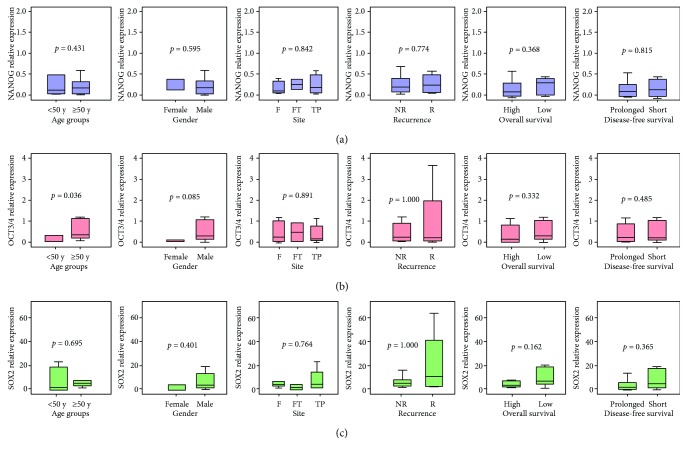
Association between gene expression and the clinicopathological features. Values are presented as medians and quartiles of fold change relative to controls. The box defines upper and lower quartiles (25% and 75%, resp.) and the whisker bars indicate upper and lower adjacent limits. TBP was used as an internal control. Noncancer tissues were set to have a relative expression value of 1.0. Mann–Whitney U and Kruskal-Wallis tests were used for comparison. p value < 0.05 was considered statistically significant. F: frontal tumor site; FT: frontotemporal; TP: temporoparietal; R: recurrent; NR: nonrecurrent.